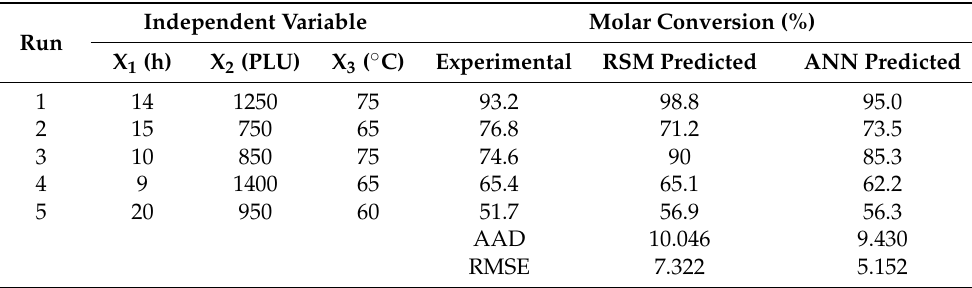
Table 3. Validation and comparison of RSM- and ANN-modeling biocatalysis.